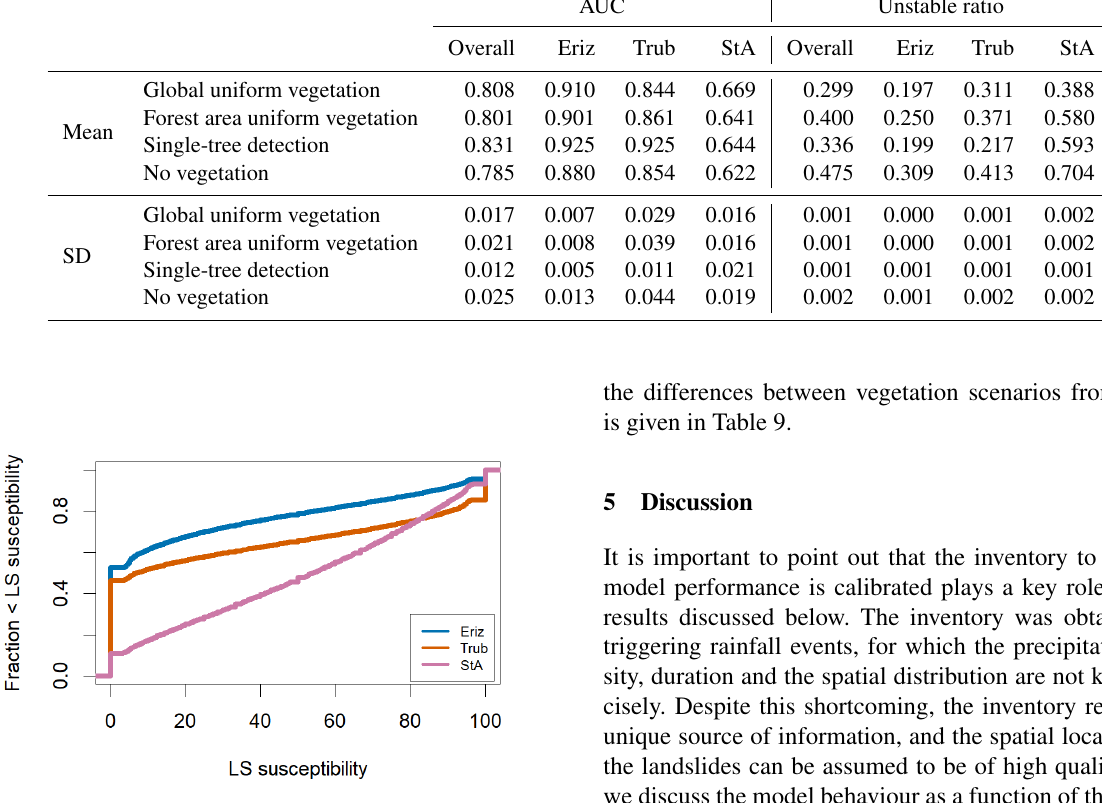
Figure 8. Cumulative plots for shallow-landslide probability in the study areas, derived from the results in Fig. 7.